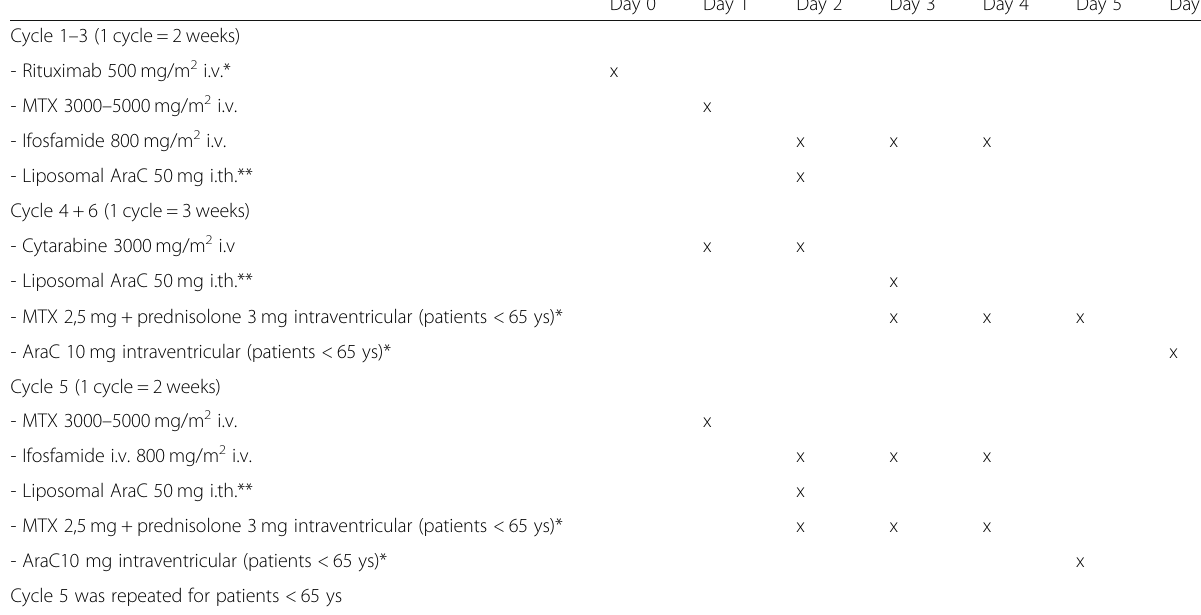
Table 1 Overview of the intended chemotherapy protocol (* patients treated 2009 – 2013, ** patients treated 2005 – 2008, i.v. = intravenous, MTX = methotrexate, AraC = cytarabine, i.th. =